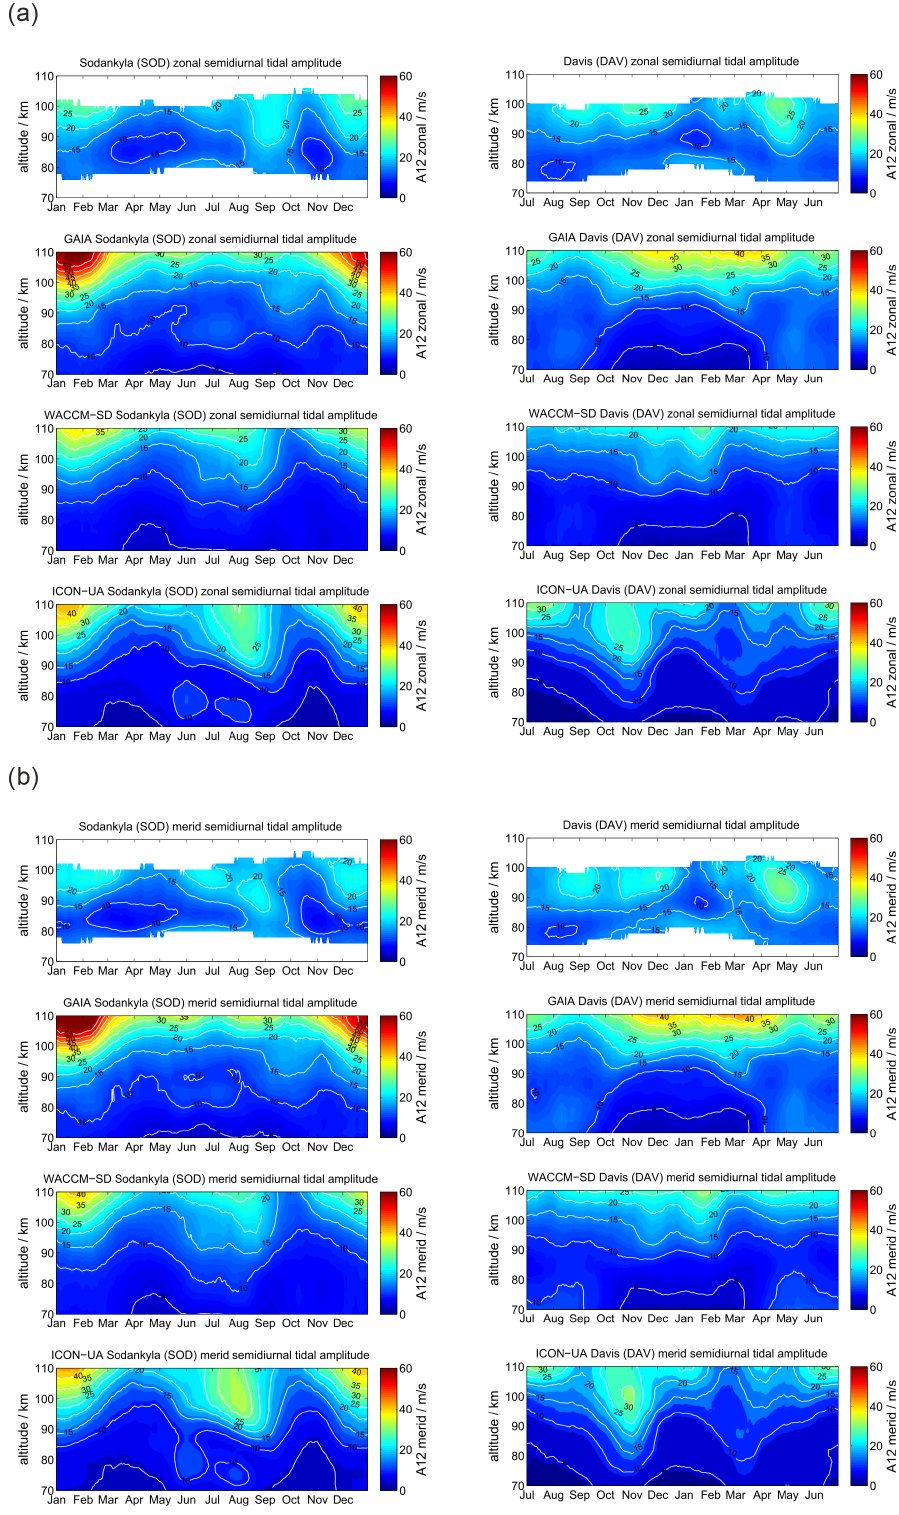
Figure 6. The same as Fig. 2, but for the semidiurnal tidal amplitudes.